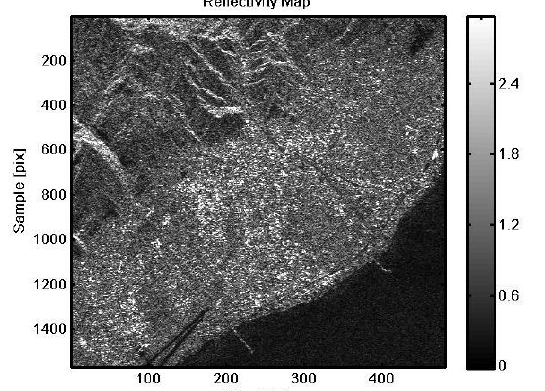
Figure 5. Reflectivity map processed in SARPROZ in